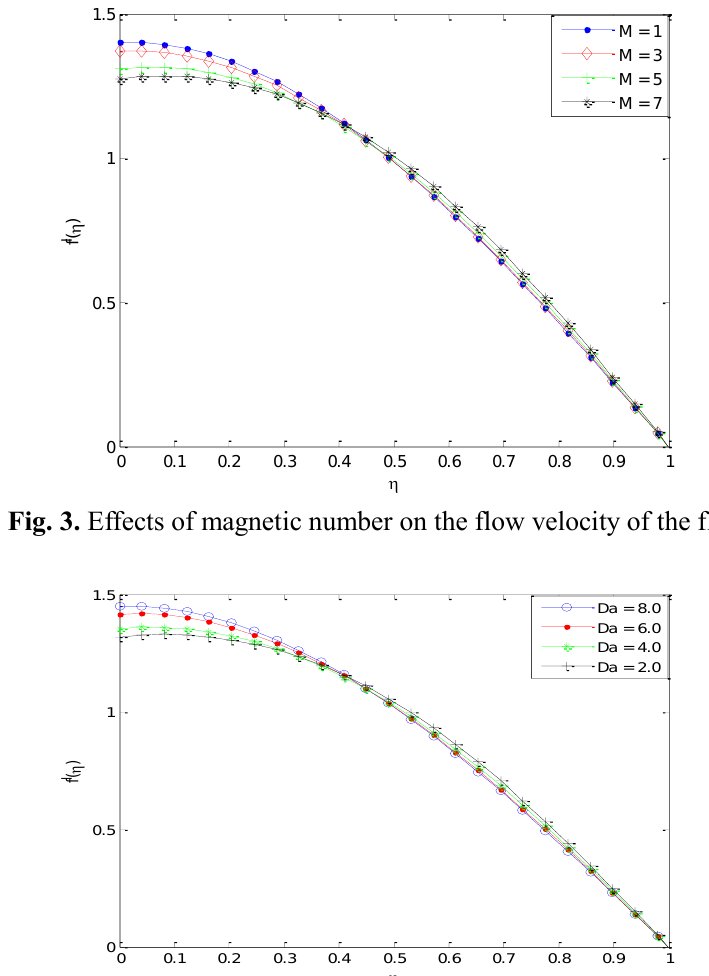
Fig. 4. Effects of Darcy number on the flow velocity of the